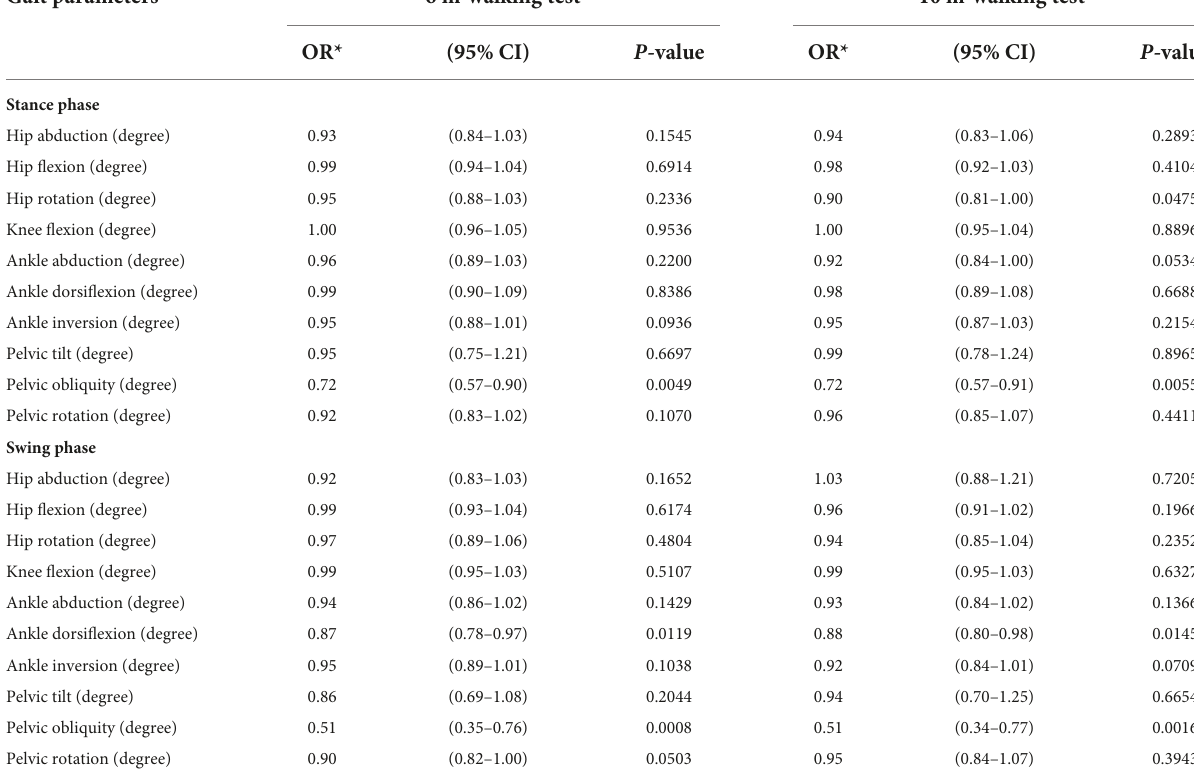
TABLE 3 Results from the logistic regression models: OR (95% CI)* for MCI, associated with gait parameters. Gait